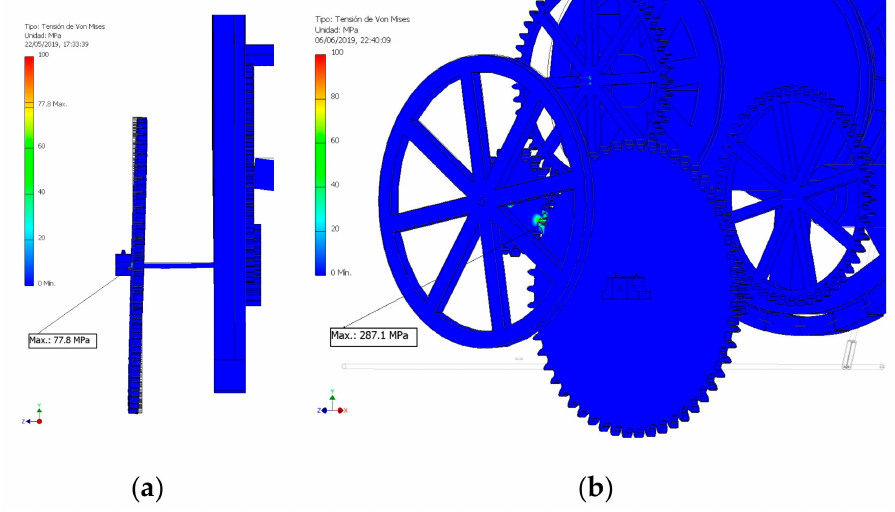
Figure 19. Location of the second highest von Mises stress: ( a ) blocking situation and ( b ) braking Figure19. LocationofthesecondhighestvonMisesstress: ( a )blockingsituationand( b )brakingsituation. situation.